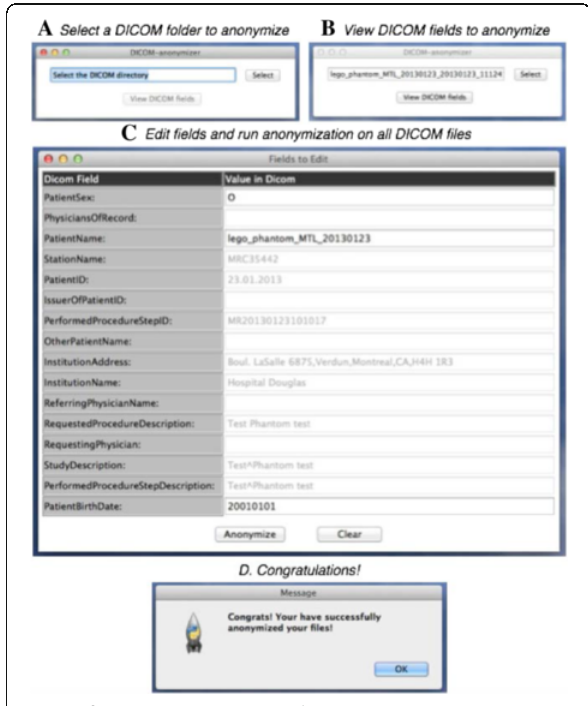
Fig. 4 (abstract A5). How to use the DICOM anonymizer step by